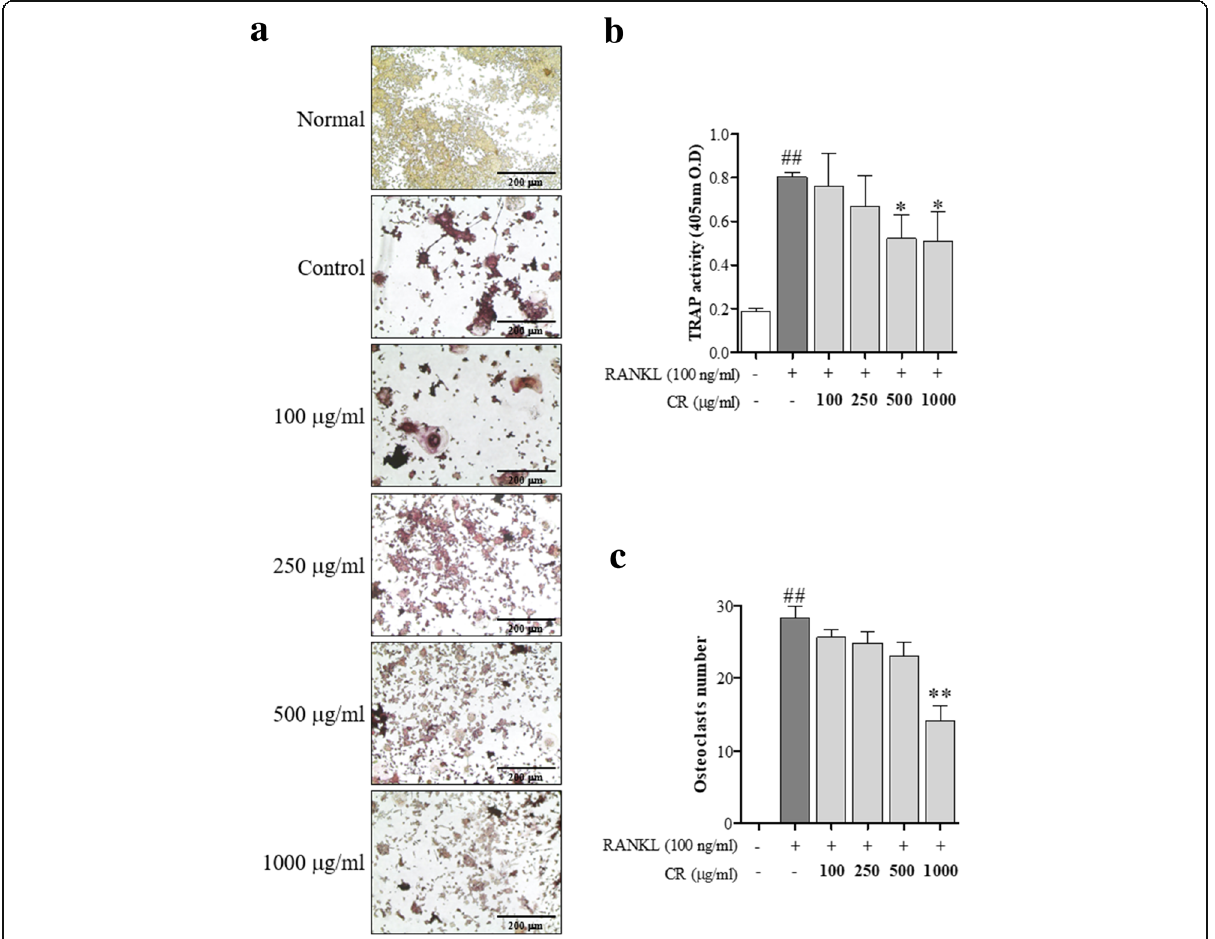
Fig. 3 Effect of CR on osteoclast differentiation. The cells were stained with the TRAP assay kit, and media were collected for the TRAP activity. a TRAP- positive multinuclear cells were captured using an inverted microscope (100×, Scale bars: 200 μ m). b Cells were counted, and c the media were measured for TRAP activity by an ELISA reader. Columns and error bars represent the mean±S. E of three independent experiments. ## p <0.01 compared with normal and ** p <0.01, * p <0.05 compared with the